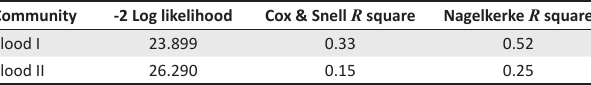
TABLE 3: Model summary. Community